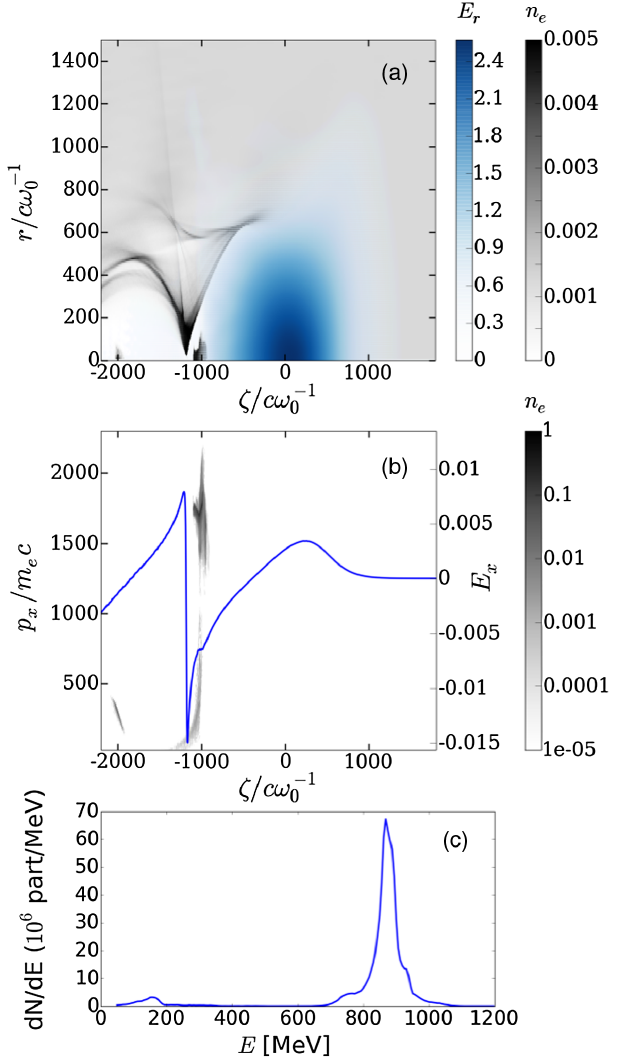
FIG. 5. Monoenergetic electron acceleration in the blowout regime. All quantities are shown at x ¼ 4 cm (two Rayleigh lengths). (a) Snapshot of electron density (in units of n , gray), c c ω 0 =e , blue). (b) The longi- and the laser field (in units of m e c ω 0 =e , blue) and normalized tudinal field E on axis (in units m x e density of electrons in the longitudinal phase space (gray). (c) Electron energy spectrum.